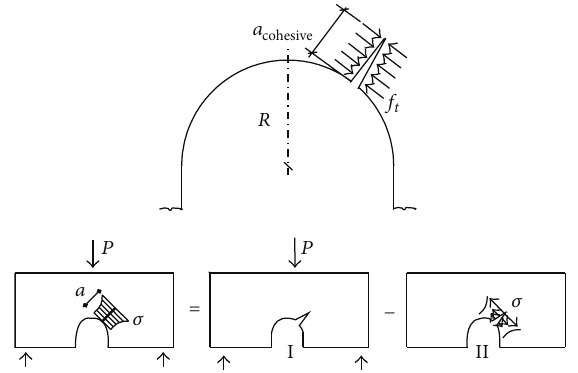
Figure 5: Cohesive crack and superposition